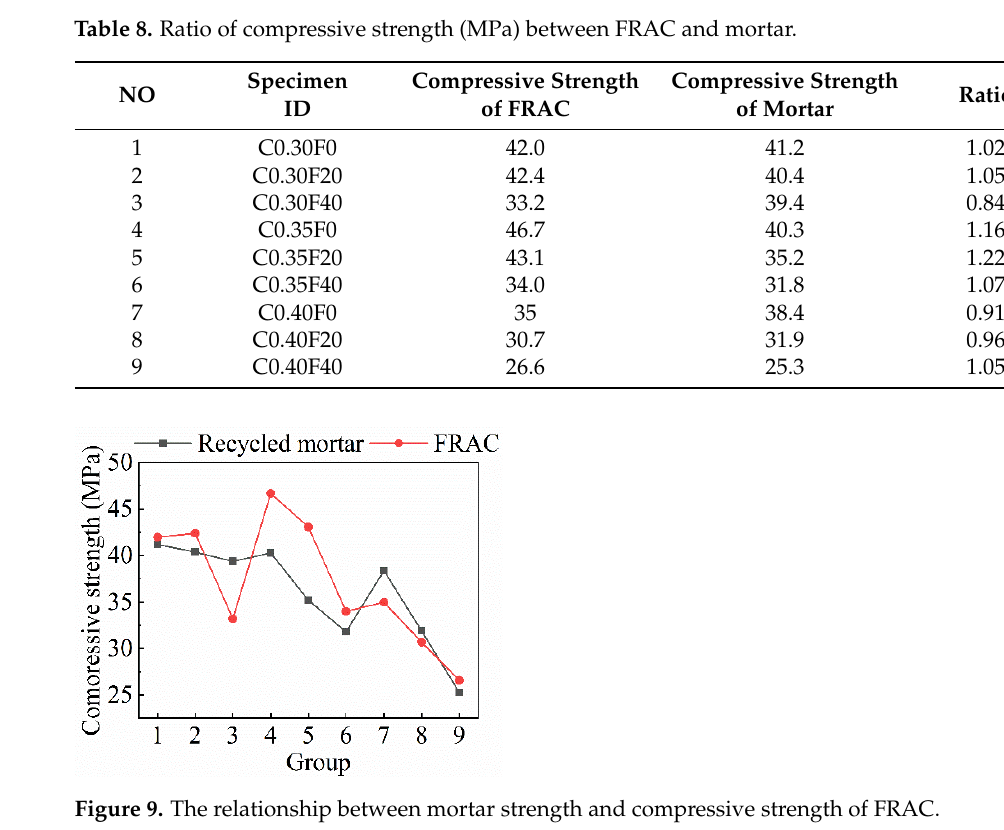
Figure 8. Variation of FRAC compressive strength with fly ash replacement ratio.